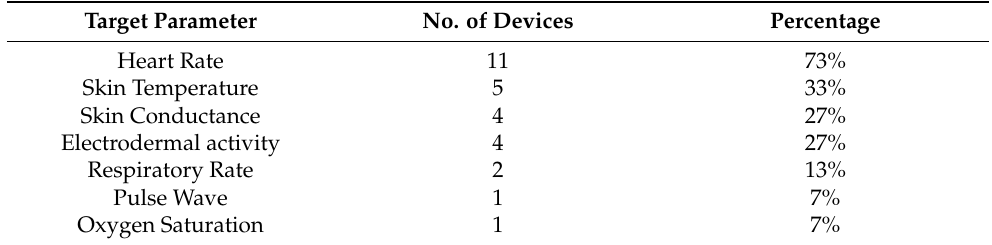
Table 6. Physiological Parameters for Engagement Detection by Non-Commercial Wearables. Target Parameter No. of Devices Percentage Heart Rate 11